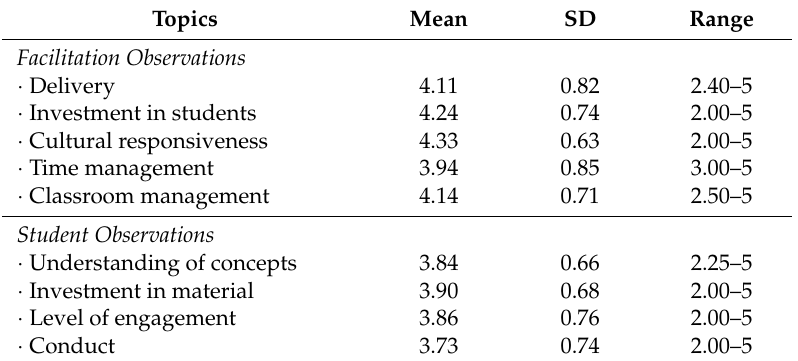
Table 1. Facilitation and Student Observations ( n = 48 completed observation